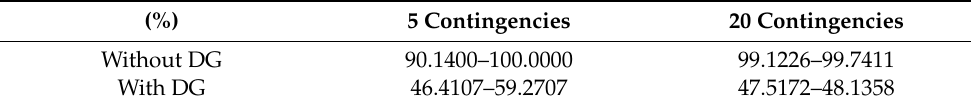
Table 6. Reliability